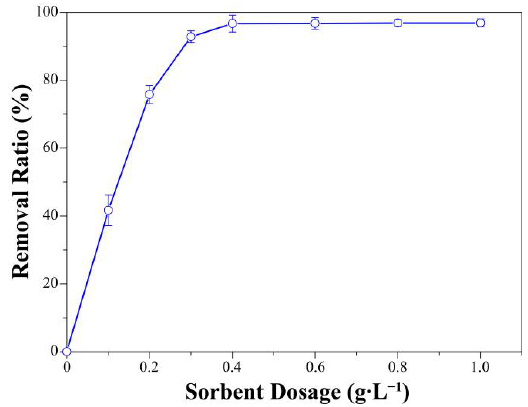
Figure 8. U(VI) removal ratio versus sorbent dosage (C 0 : 29.8 mg∙L −1 , NaF: 2 g∙L −1 , volume: 1 L, time: 144 h, and temperature: 25 °C).